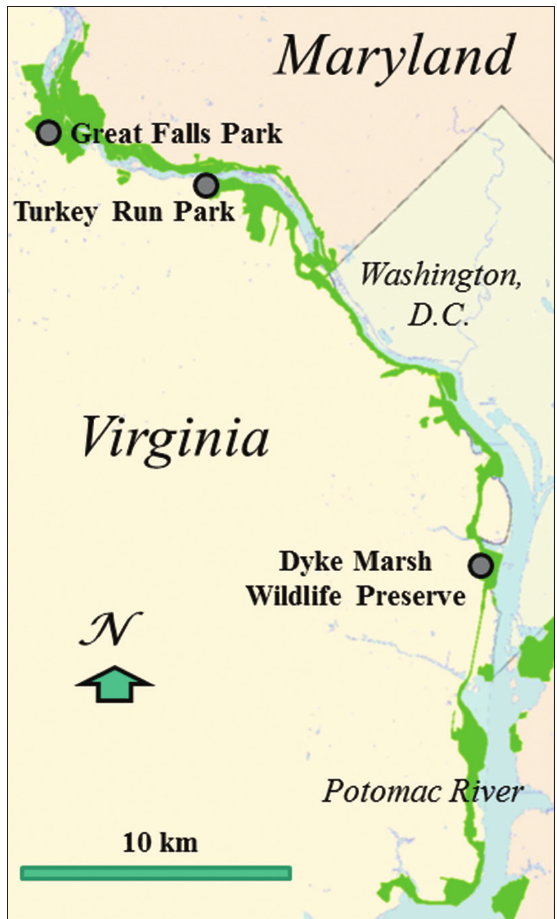
Figure 1. Locations of sawfly sampling sites. Dyke Marsh Wildlife Preserve, Great Falls Park, and Turkey Run Park within the George Washington Memorial Parkway (GWMP) in